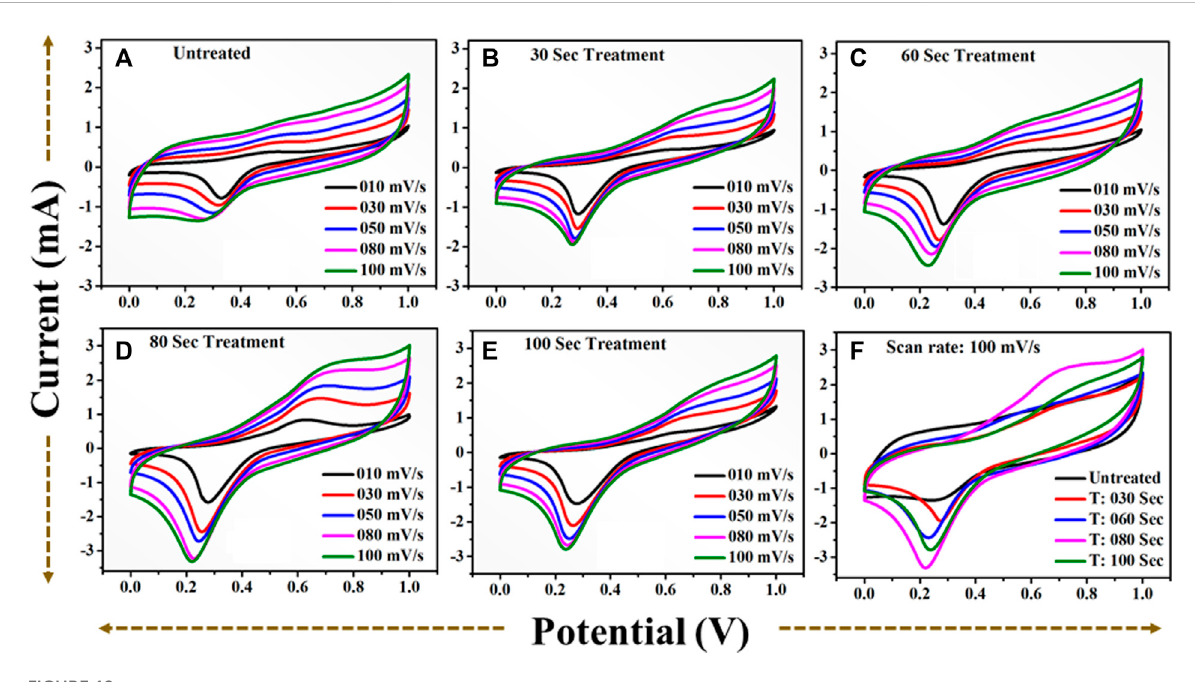
FIGURE 12 CVpro fi leinpositivepotentialwindow (A) :foruntreatedTiO 2 atscanrate(10 – 100)mV/s. (B) :for30 splasmatreatedTiO 2 atscanrate(10 – 100) mV/s. (C) :for 60 splasmatreatedTiO 2 atscanrate(10 – 100)mV/s. (D) :for80 splasmatreated TiO 2 atscanrate(10 – 100)mV/s. (E) :for100 splasma treated TiO 2 at scan rate (10 – 100) mV/s. (F) : A comparative CV pro fi le for (A – E) at scan rate 100) mV/s.